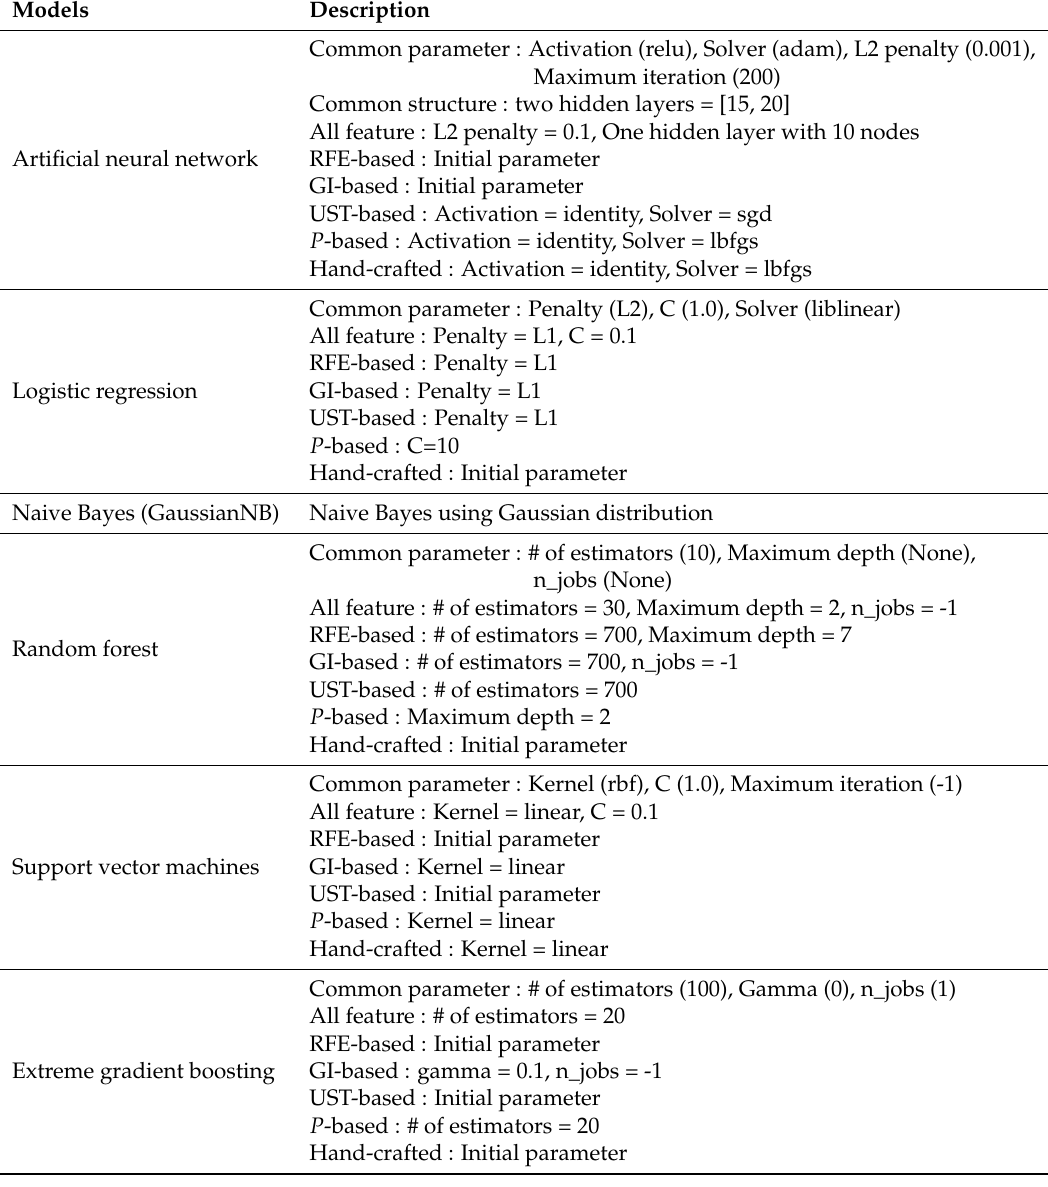
Table 4. Parameter settings for machine learning